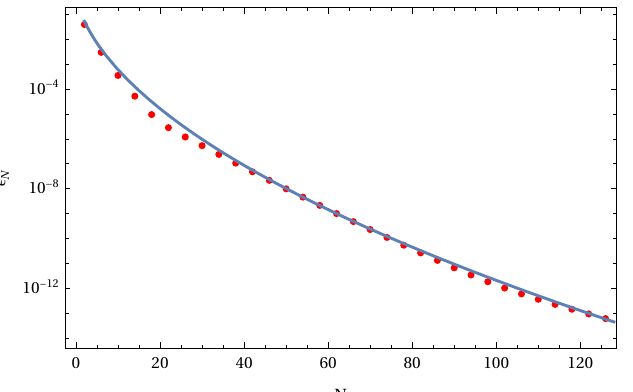
(cid:16) (cid:17) 1/2 − k with K 2 = 2.623 and k 2 = 3.017. 2 N